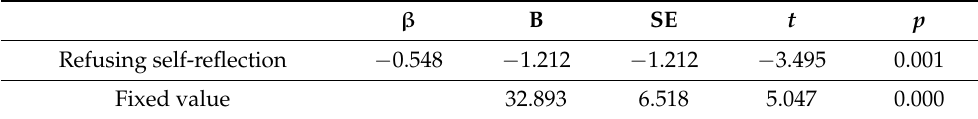
Table 5. Predictors of satisfaction with life.